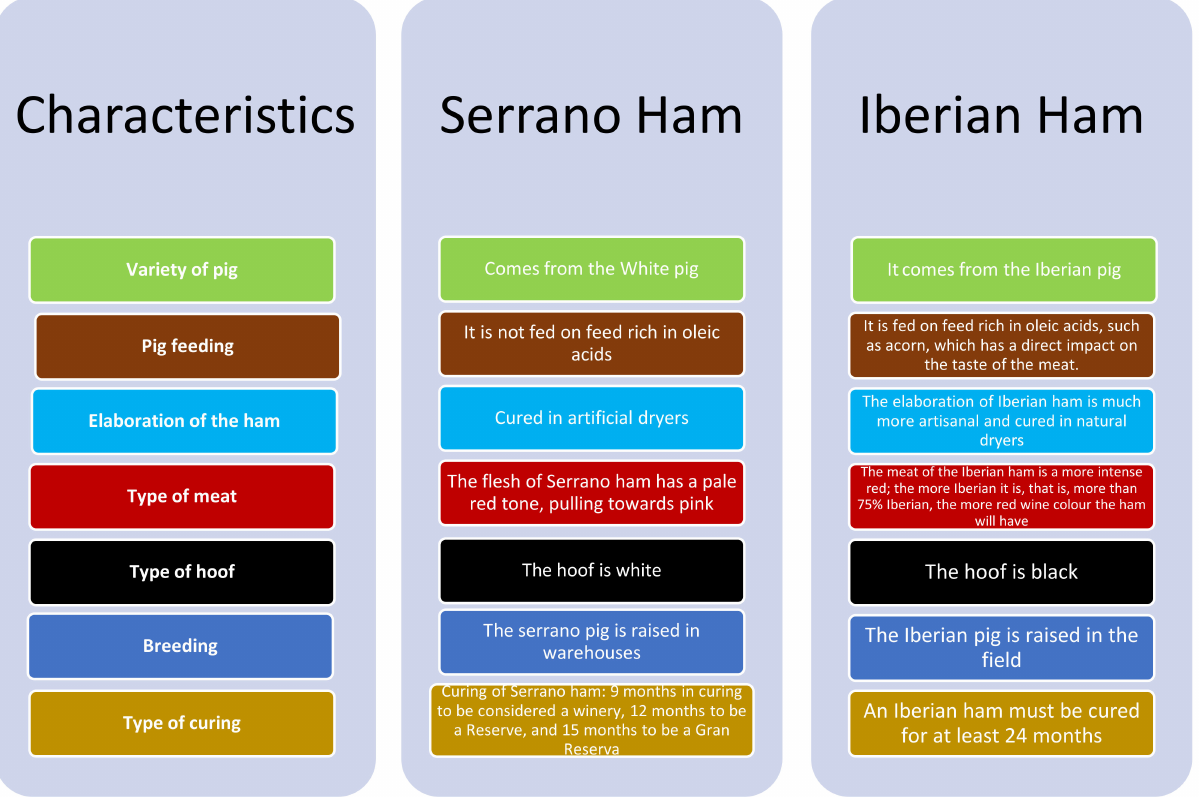
Figure 3. Differences between Serrano ham and Iberian ham. Source: own